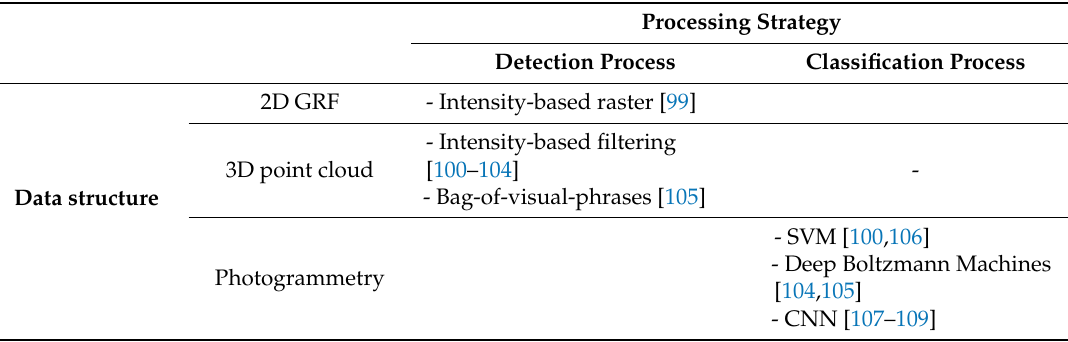
Table 4. Summary of state-of-the-art works for tra ffi c sign